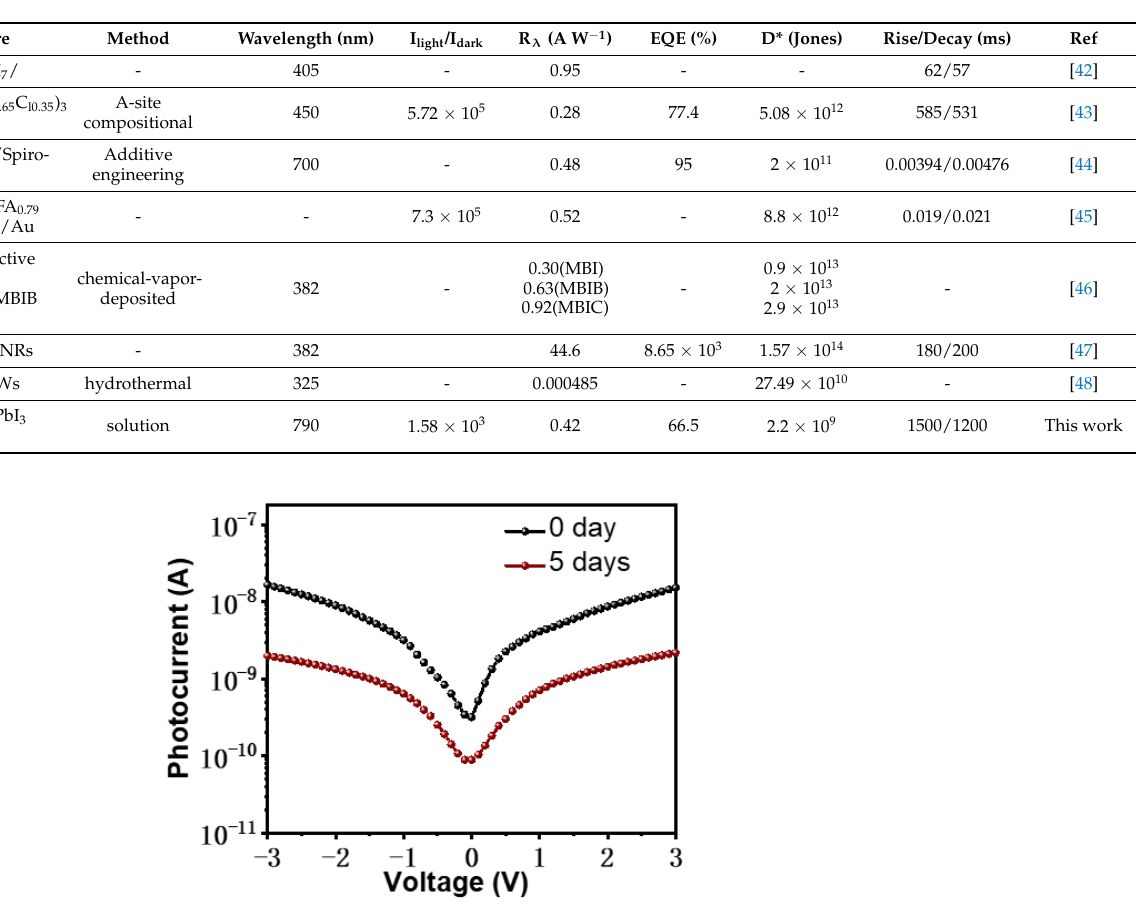
Table 2. Performance comparison of different photodetectors.